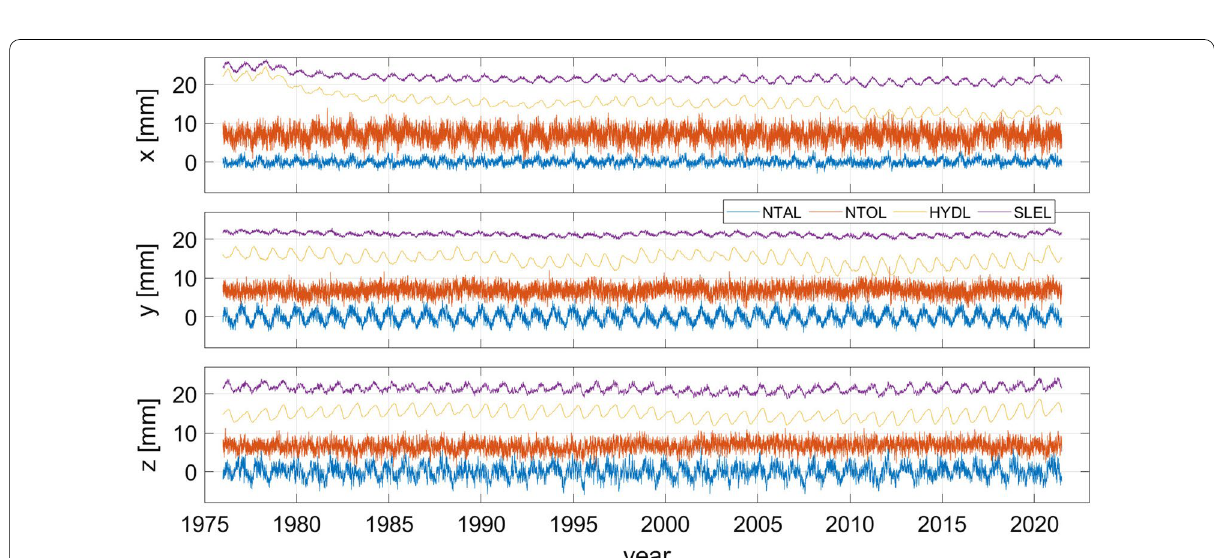
Fig. 8 Same as Fig. 7, but this time the geocentre motion contributions refer to ESMGFZ. Hence, there is an additional component generated by the sea level loading (SLEL), which has been shifted by 21